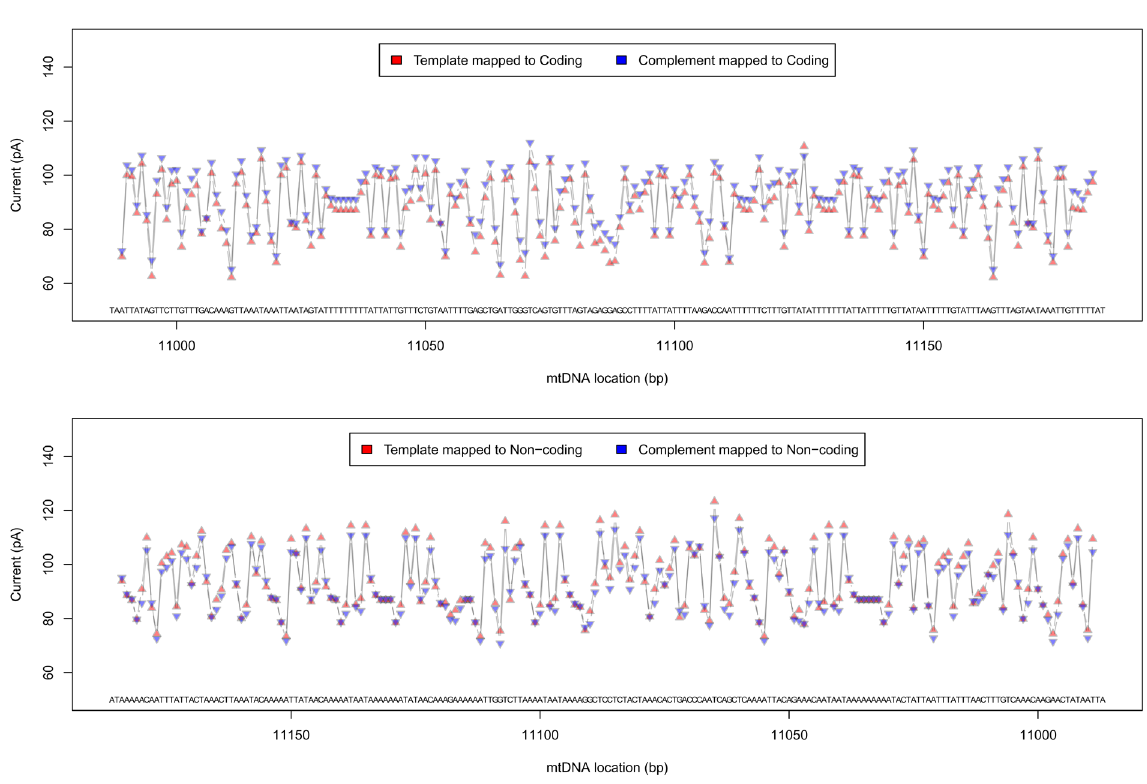
Figure 4. Ideal event plot, CytB gene tail. Ideal event trace for 200 pentamers at the tail end of the Cytochrome B gene. The complement sequence has a slightly lower current than the template sequence for reads mapped to the coding strand, and also a slightly lower current for reads mapped to the non-coding